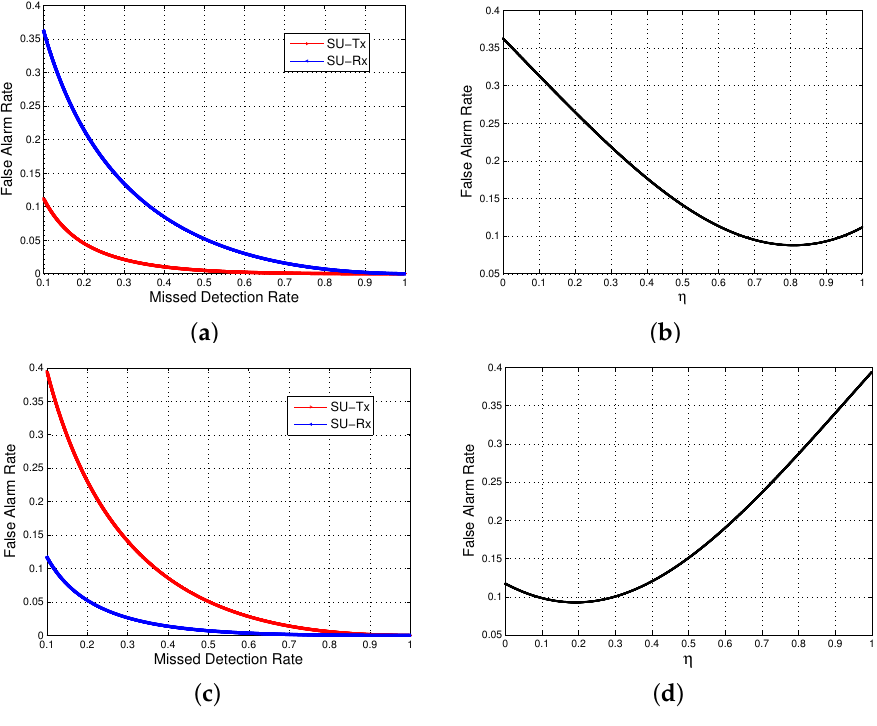
Figure 4. The false alarm rates of an individual sensor versus cooperative sensing. ( a ) ROC of an individual sensor ( ρ tx > ρ rx ); ( b ) false alarm rate of sensing fusion ( ρ tx > ρ rx ); ( c ) ROC of an individual sensor ( ρ tx < ρ rx ); ( d ) false alarm rate of sensing fusion ( ρ tx < ρ rx